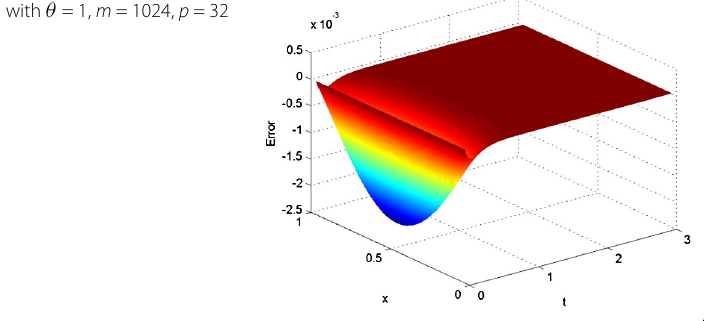
Figure 6 Errors of (32) with θ = 1, m = 1024, p = 32 and r =